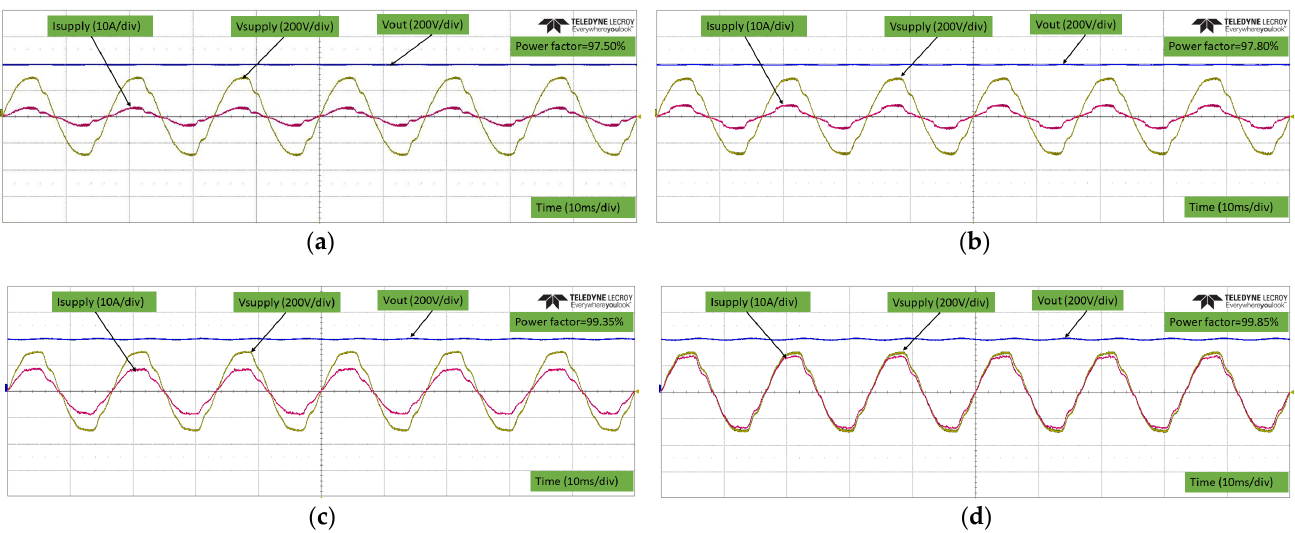
Figure 25. Input and output voltages, input current, and power factor of the designed interleaved PFC converter with different loading condition. ( a ) 25%; ( b ) 50%; ( c ) 75%; ( d ) 100%.